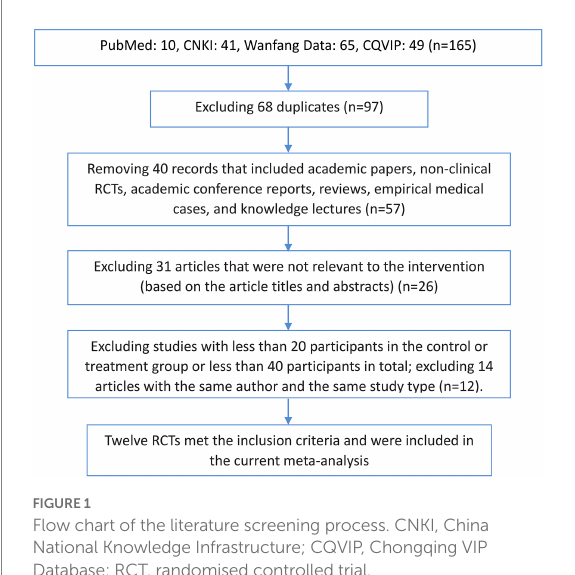
FIGURE 1 Flow chart of the literature screening process. CNKI, China National Knowledge Infrastructure; CQVIP, Chongqing VIP Database; RCT, randomised controlled